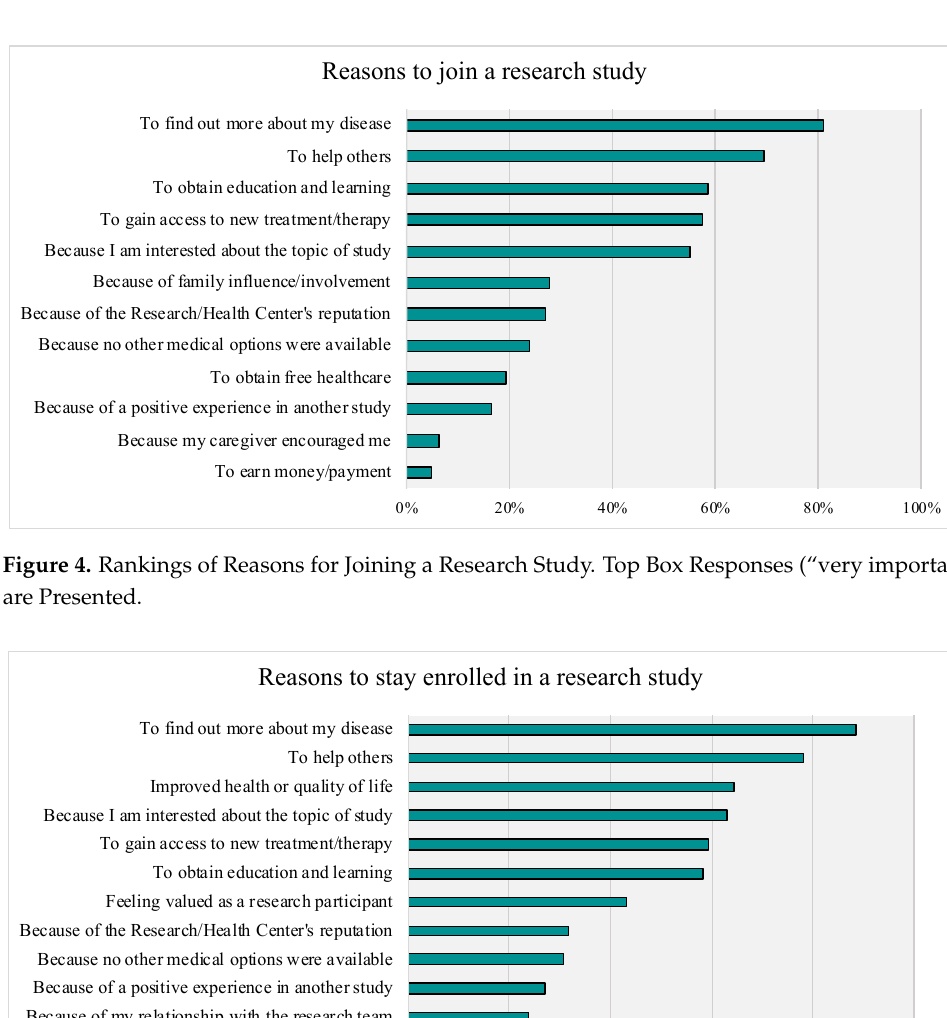
Figure 3. Prior Research Participation.